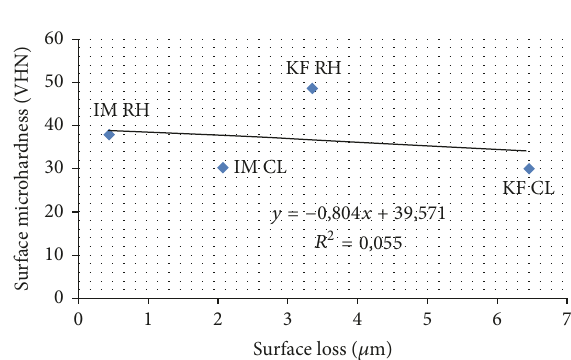
Figure 4: Regression analysis between surface microhardness (VHN) and surface loss after abrasion ( 𝜇 m) of the experimental groups. KF CL: Ketac Fil Plus Aplicap control group, KF RH: Ketac Fil Plus Aplicap radiant heat group, IM CL: IonoStar Molar control group, and IM RH: IonoStar Molar radiant heat